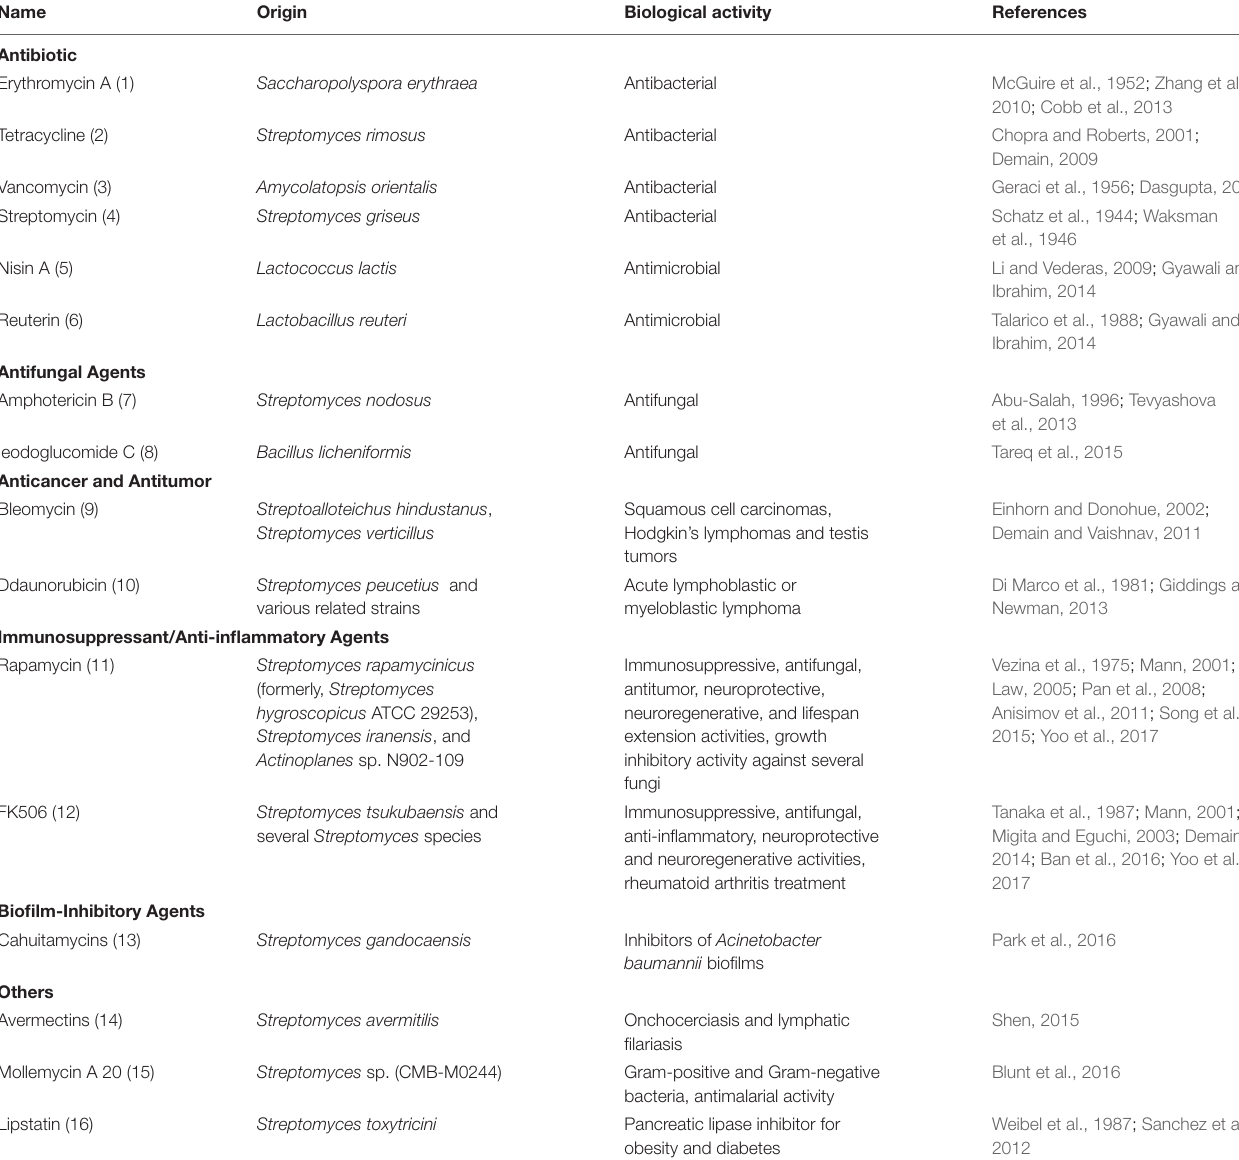
TABLE 1 | Biological activities of microbial-derived natural products and